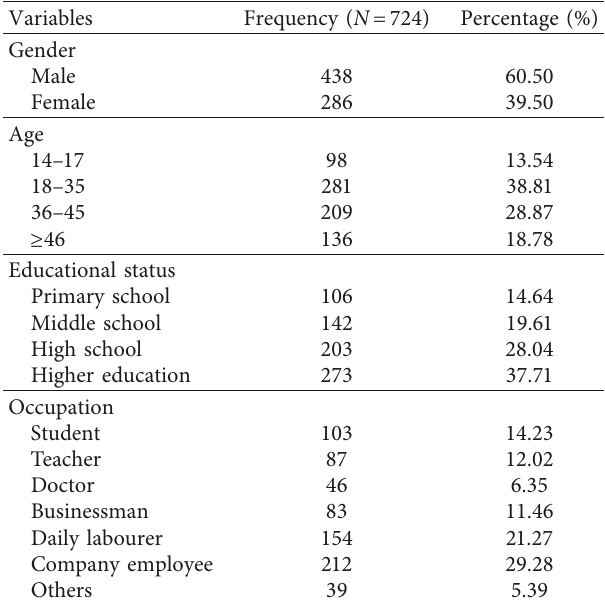
Figure 2: The trend of shared bicycle-related injuries increased during the study period from 105 in 2017 to 184 in 2021. Table 1: Demographical characteristics of patients with shared bicycle-related